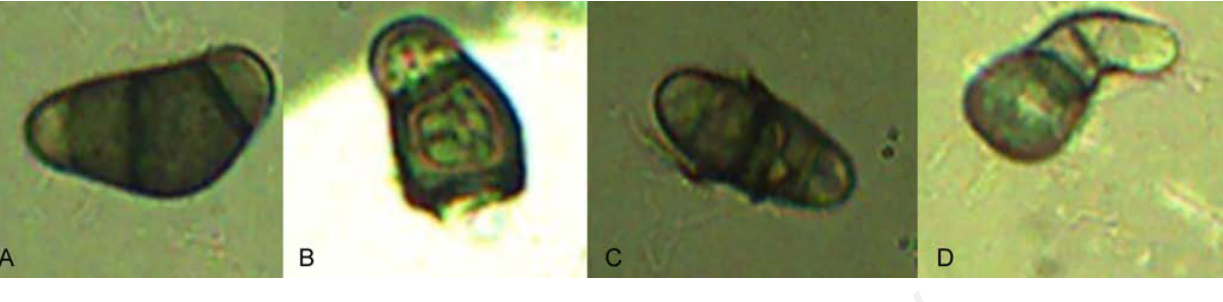
Figure 1. Effects of hexane, EtoAC and methanol extracts from C. cupreum CC3003 on spores of C. lunata. A) 0 µg/mL; B) Hexane- crude extract 1000 µg/mL; C) EtOAC-crude extract 1000 µg/mL; D) Methanol-crude extract 1000